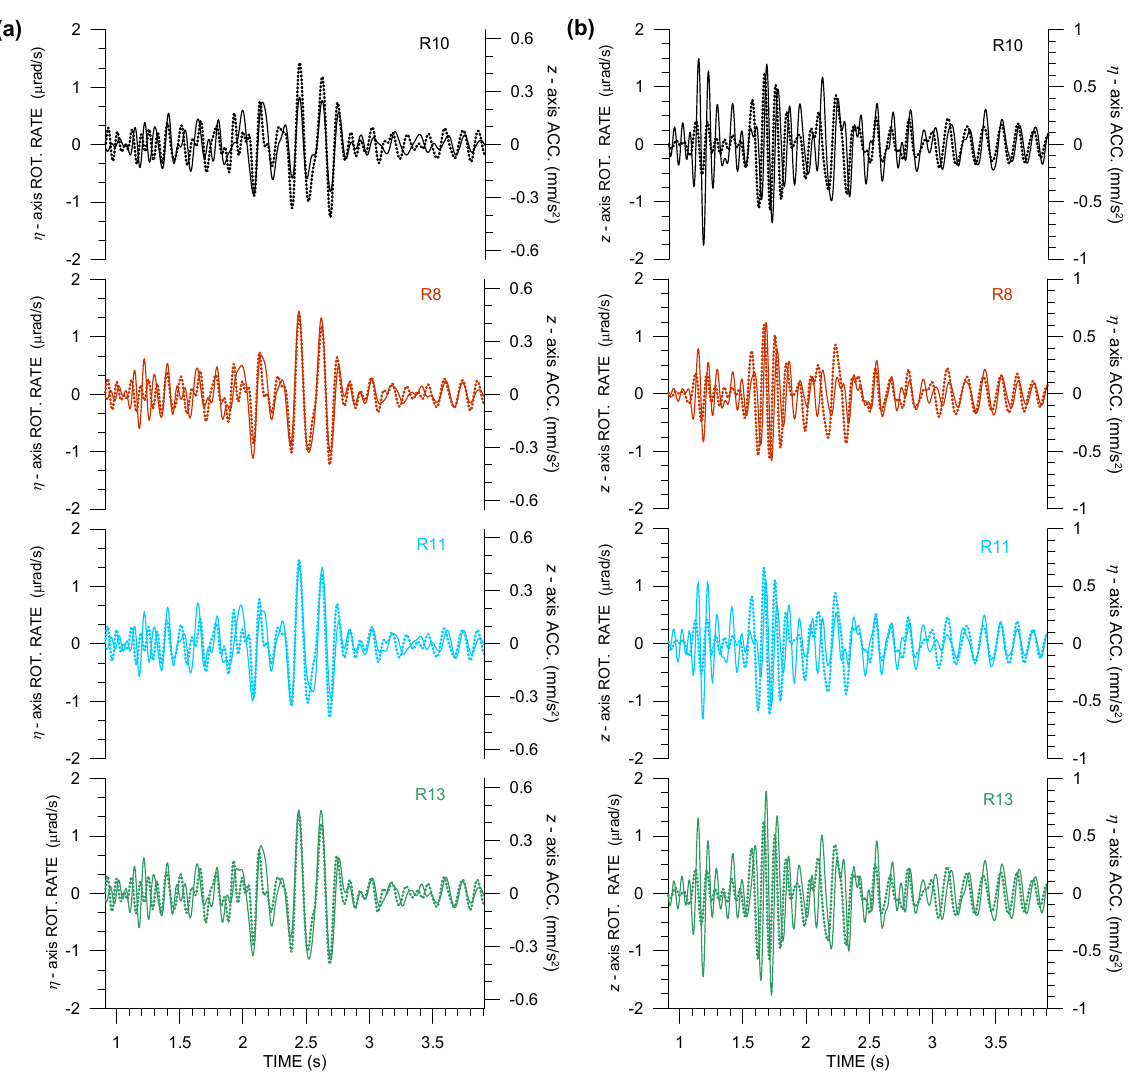
Figure 10. Waveform matching of the relevant rotation rate (solid) and ground acceleration (dotted) components in records of Expl4 in the active part of the GOF experiment from four 6C Rotaphone-CY instruments (R8—red, R10—black, R11—light blue, and R13—green): rotation rates around the transverse axis and vertical ground acceleration ( a ), and rotation rates around the vertical axis and transverse ground acceleration ( b ). The transverse axis is perpendicular to the geometrical azimuth of 293.0 ◦